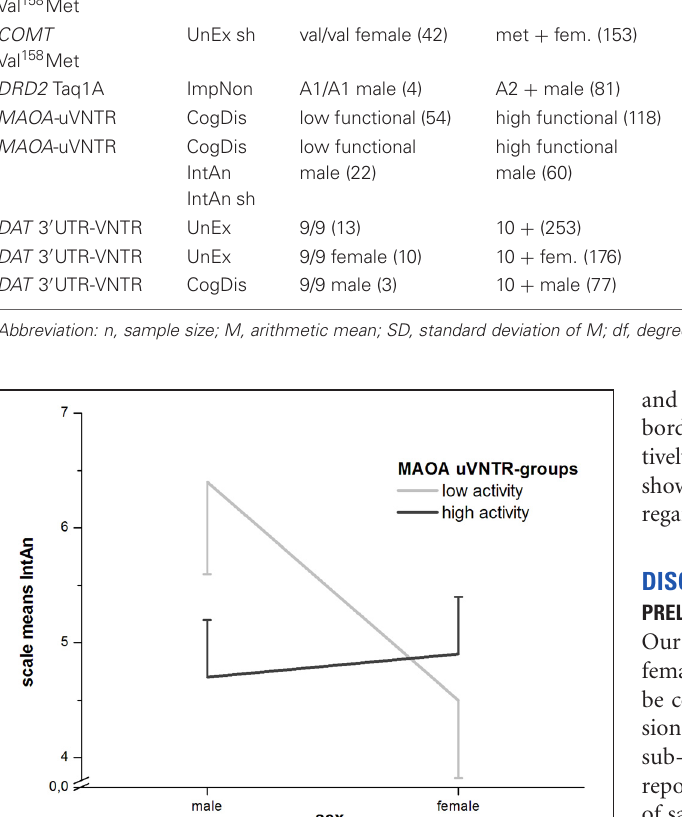
and short IntAn-scales (full scale: F 1 = 5 . 91; p = 0 . 016 and short scale: F 1 = 3 . 890; p = 0 . 05). Where males with a low-activity genotype showed higher IntAn-scores, females showed equal or even lower (for the full scale) scores in the low-activity group (see Figure 1